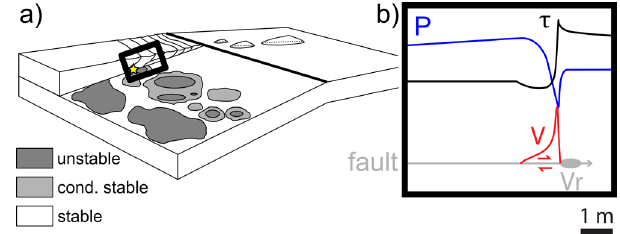
Fig. 5 Conceptual model of earthquake propagation in shallow subduction faults. a The subduction interface has a deeper zone with locked and frictionally unstable seismogenic patches (dark grey shaded areas) where tsunamigenic earthquakes (yellow star) can nucleate, surrounded by conditionally stable areas (light grey shaded areas). Around the unstable or conditionally stable areas and especially at shallow depth, the subduction interface is stable (white shaded areas) and undergoes creep (modi fi ed from ref. 37 ). b Conceptual model of seismic slip in the conditionally stable regime. Behind the process zone of the seismic rupture (grey ellipse) propagating towards the right (into neighbouring rocks) at velocity V r ( ∼ 1 km/s), the fault slip velocity increases abruptly to ca. 1 m/s (red curve), while the fault strength decreases (dynamic fault weakening, black curve). At the same time, pore fl uid pressure inside the slip zone (blue curve) decreases by shear-induced dilatancy and then increases owing to pressurisation processes. The experimental evidences reported in this study suggest that the lower permeability of the clay-rich fault gouges typical of the shallow sections of subduction zones, promotes more rapid pore fl uid pressure increase, faster dynamic fault weakening, and lower earthquakes.